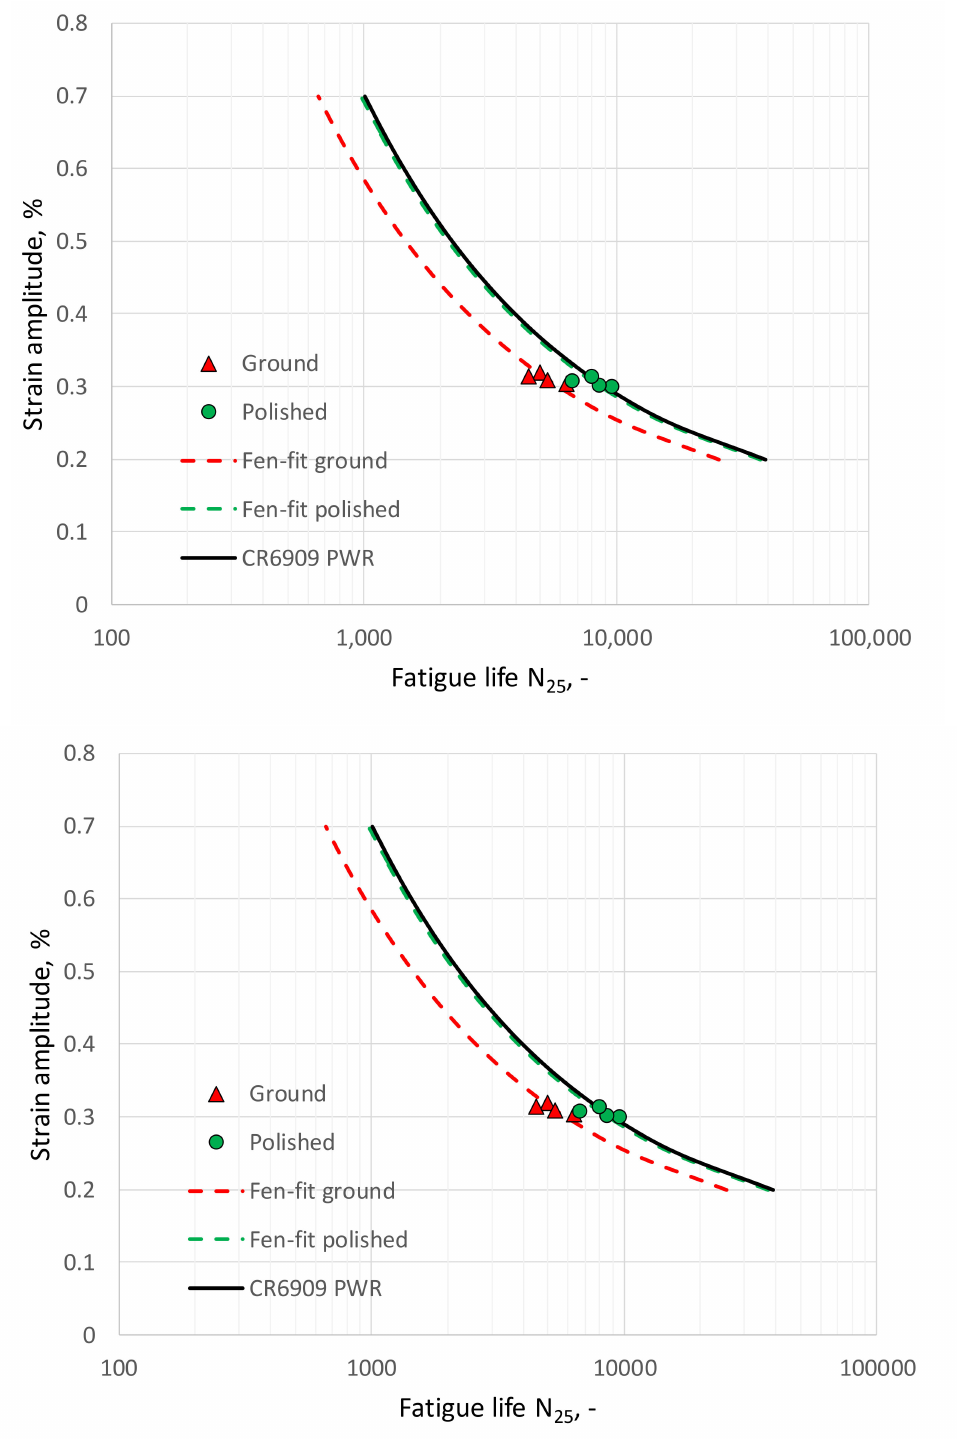
Figure 9. PWR fatigue life results (by surface finish) and NUREG / CR6909 mean PWR curve at 230 ◦ C (F en =